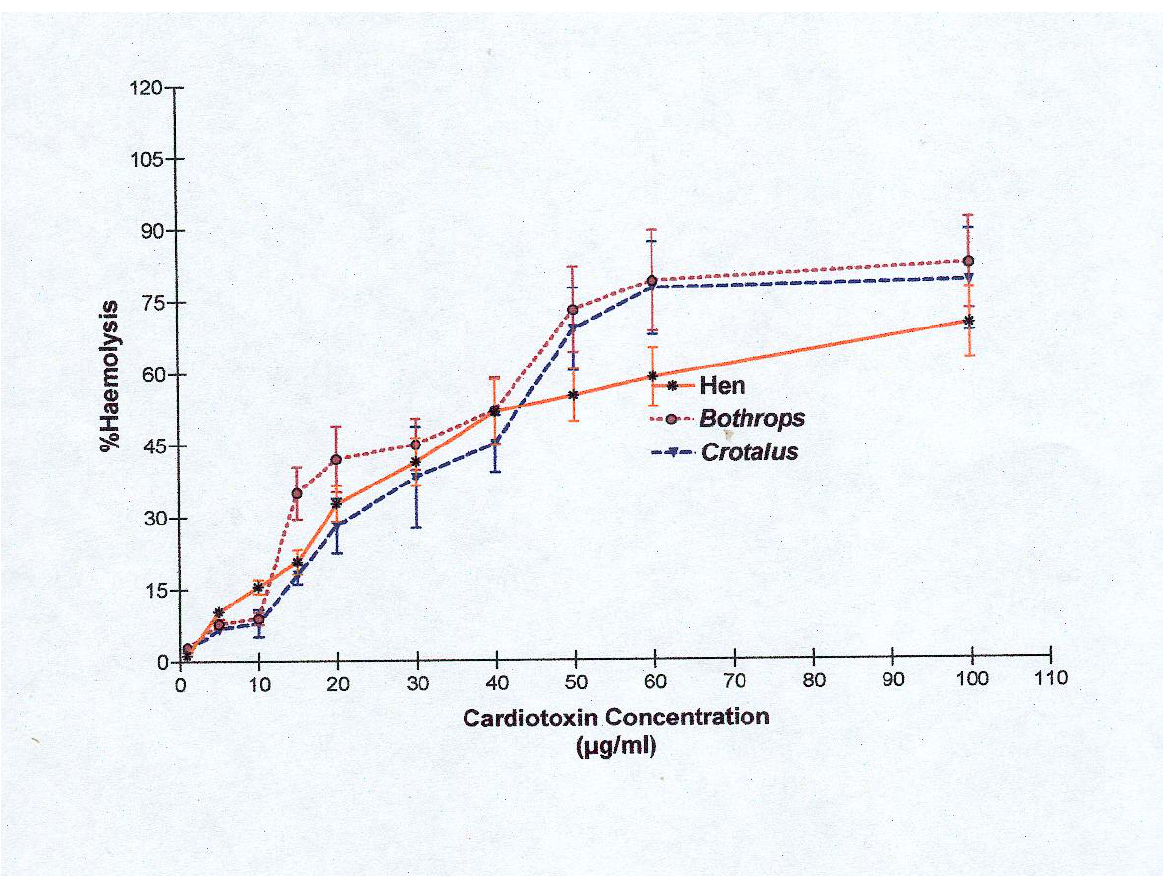
Figure 3. Cardiotoxin III hemolytic action on avian (Hen) and reptilian ( Bothrops and Crotalus ) erythrocytes. Table 1: Comparative sensitivity of different vertebrates’